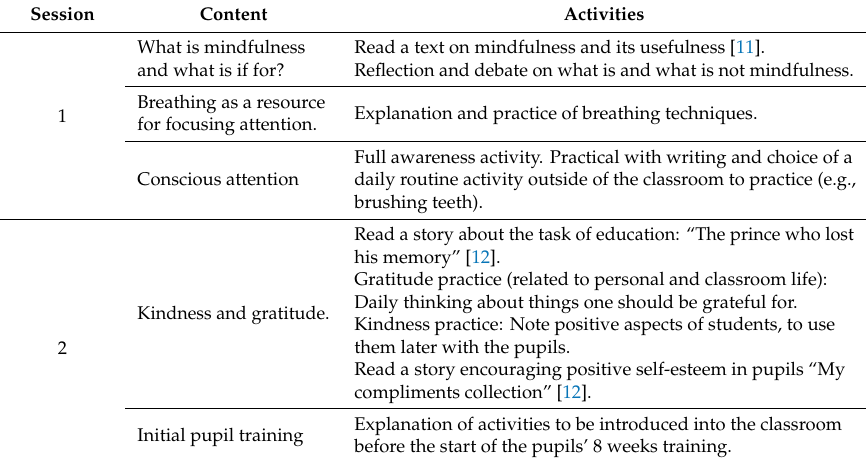
Table 2. The activities and content of the two initial training sessions for teachers.